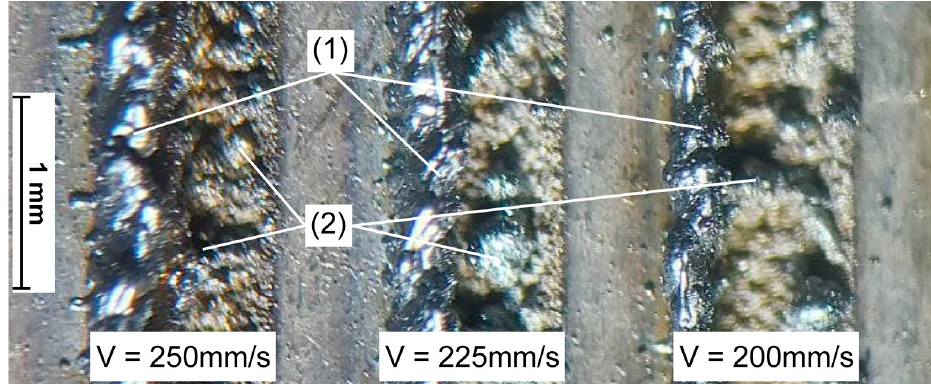
Figure 8. View of depressions at a processing speed (V) above 200 mm/s, where ( 1 ) is a single formed bead, ( 2 ) is the melt droplets remaining in the groove.